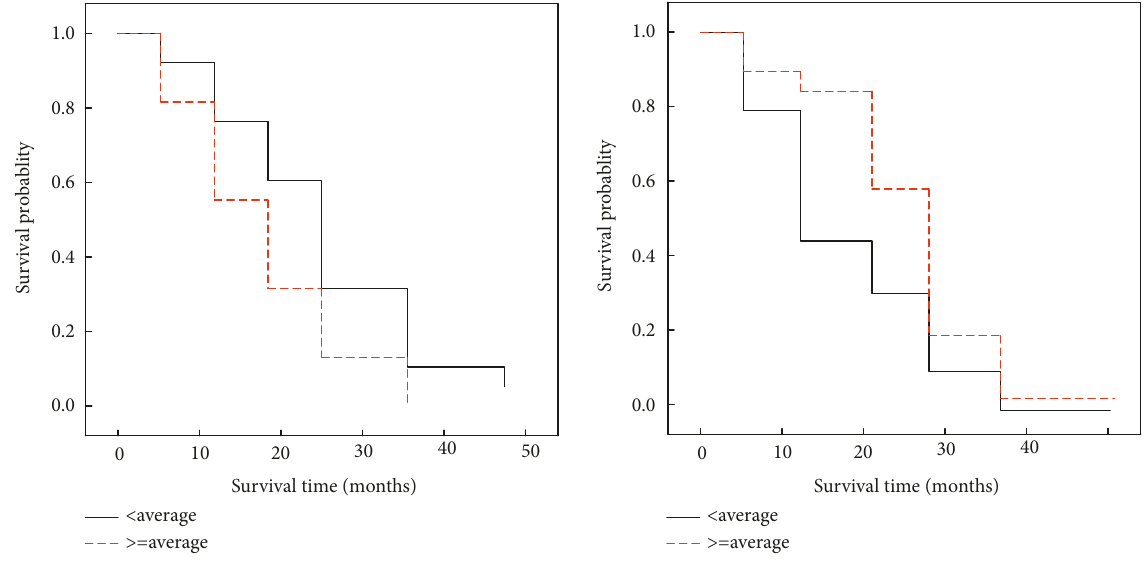
Figure 8: Two radiomics characteristic